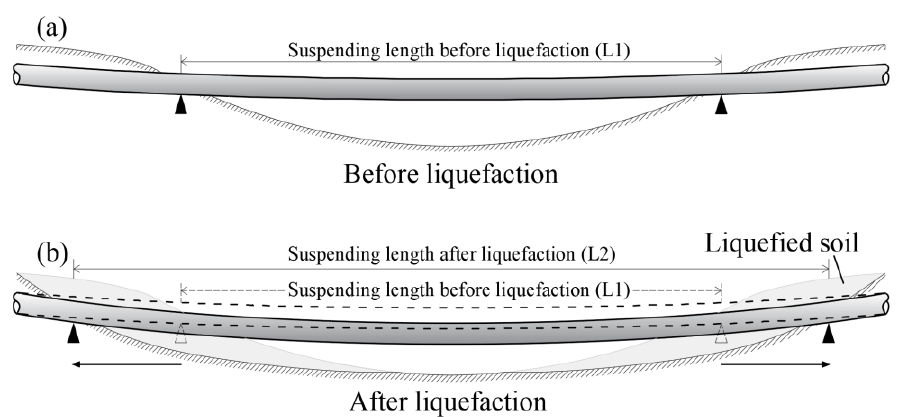
Figure 12. Schematic map showing the touchdown points of a spanning pipeline ( a ) before and ( b ) after soil liquefaction, indicating the touchdown point of the span move backward after soil liquefaction. The extended span possibly floats or sinks, depending on the specific gravity of the pipe.